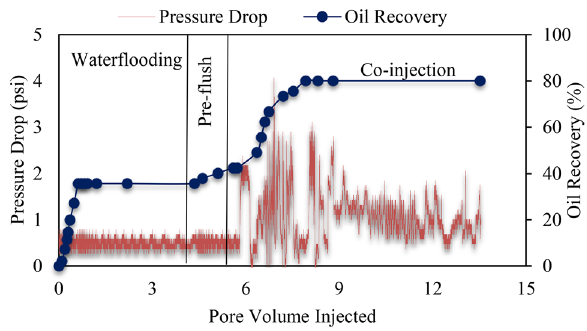
Fig. 3 Oil recovery following waterflooding and CO fractured rock